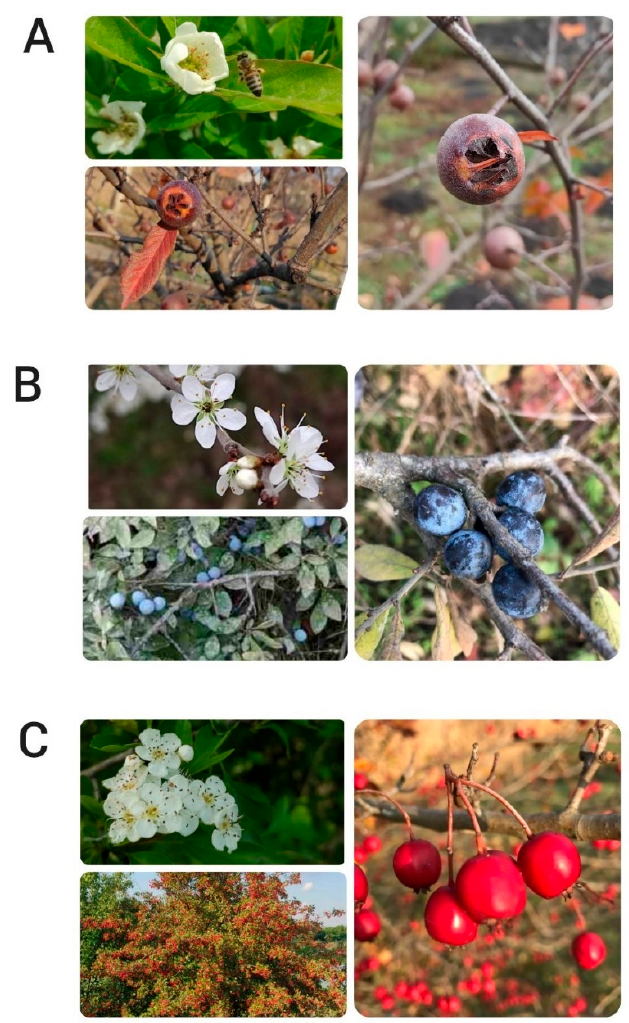
Figure 1. Developing stages and fruits of medlar ( A ), blackthorn ( B ) and common hawthorn ( C ) (photo by N. Mi ć anovi ć ).